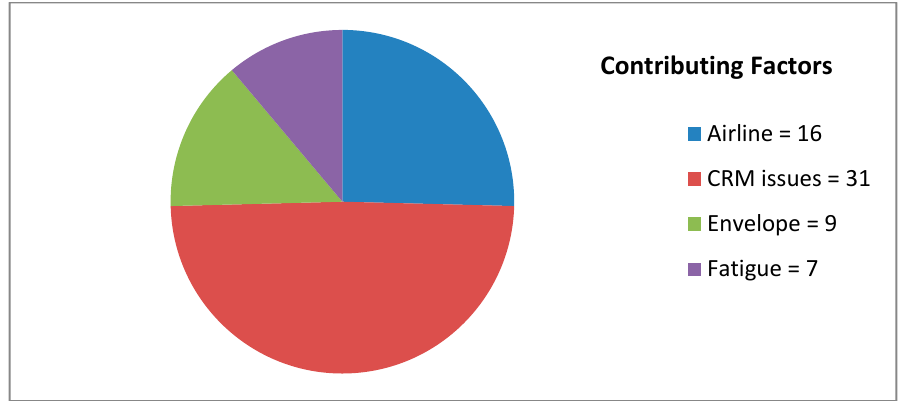
Figure 3. Other contributing factors in connection with the Part 121 accidents. CRM, Crew Resource Management.